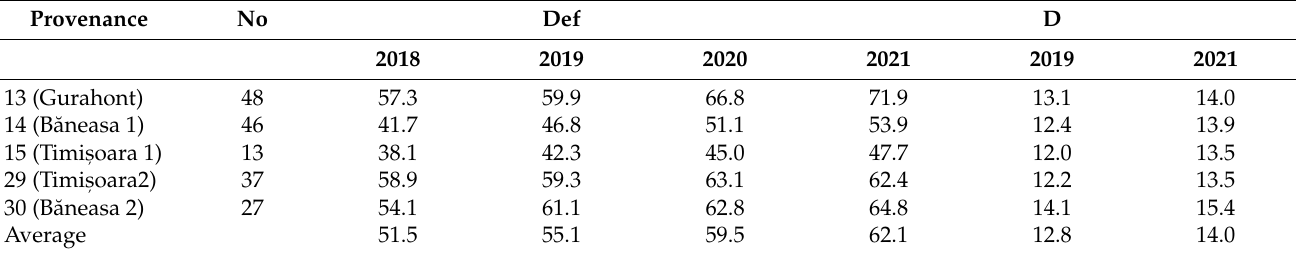
Table 4. Defoliation and diameter of Ulmus minor